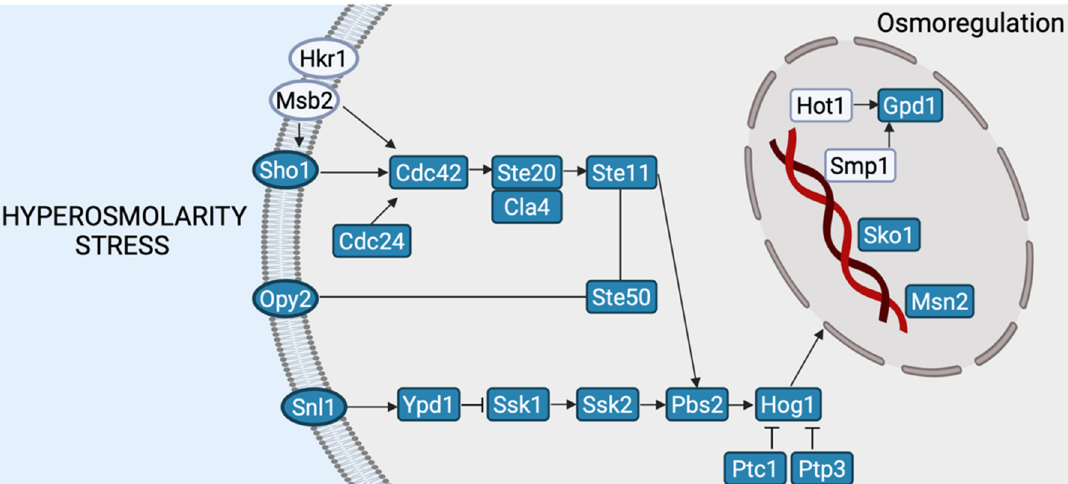
Figure 3. Model illustrating the high-osmolarity glycerol (HOG)—mitogen-activated protein kinase (MAPK) pathway in Emericellopsis cladophorae MUM 19.33, based on the Saccharomyces cerevisiae HOG-MAPK pathway. Genes that were detected are highlighted in blue. Arrows indicate possible connections. The figure was created with BioRender.com (accessed on 23 September 2021).